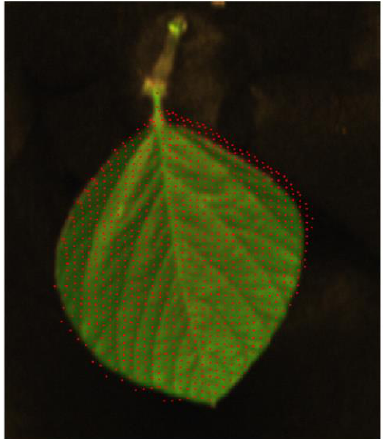
Figure 9. Using the fusion model proposed in this paper to derivate Kinect V2 depth information to hyperspectral image coordinate information.